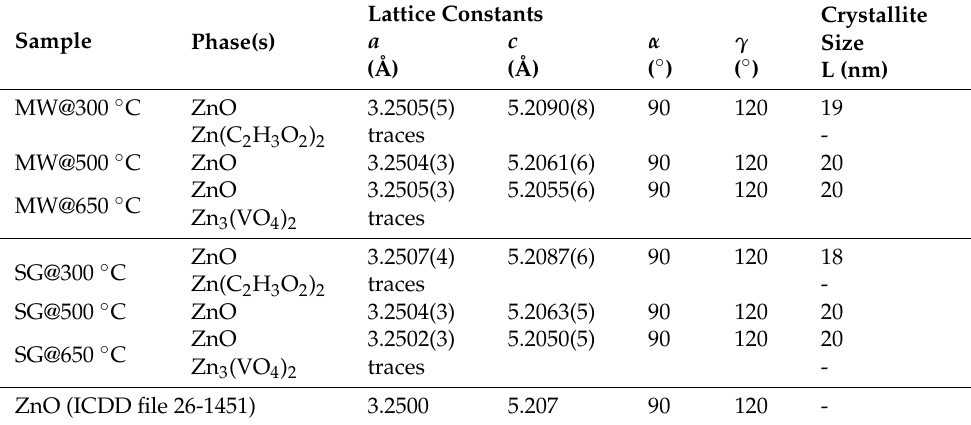
Table 2. The lattice parameters and the average crystallite